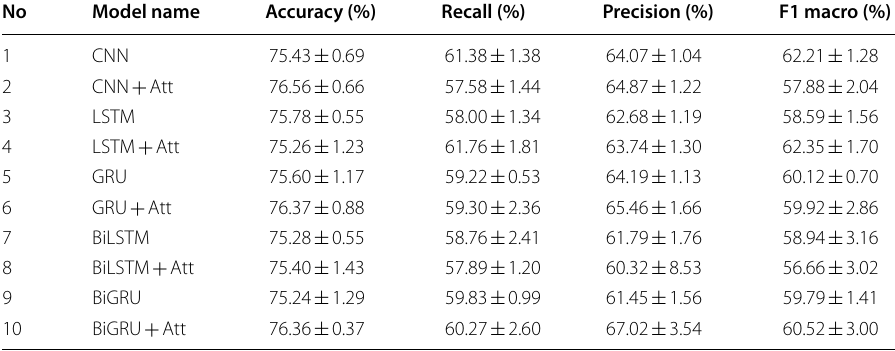
Table 3 Result of argument annotation using deep learning model with attention mechanism (Word Embedding from